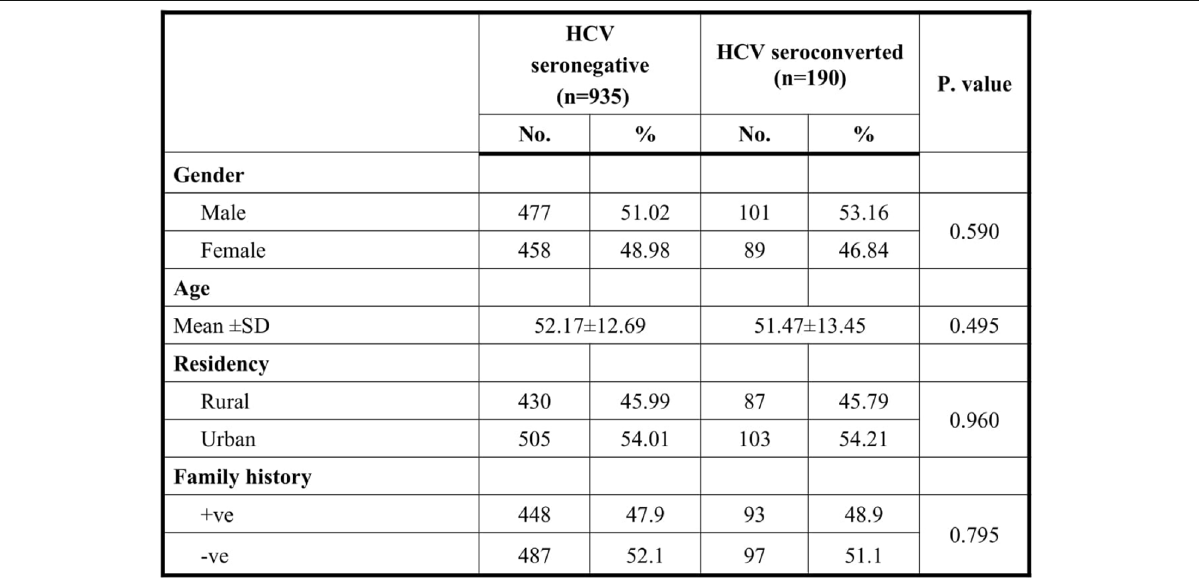
Table 2 Comparison of demographic data between HCV seronegative and seroconverted